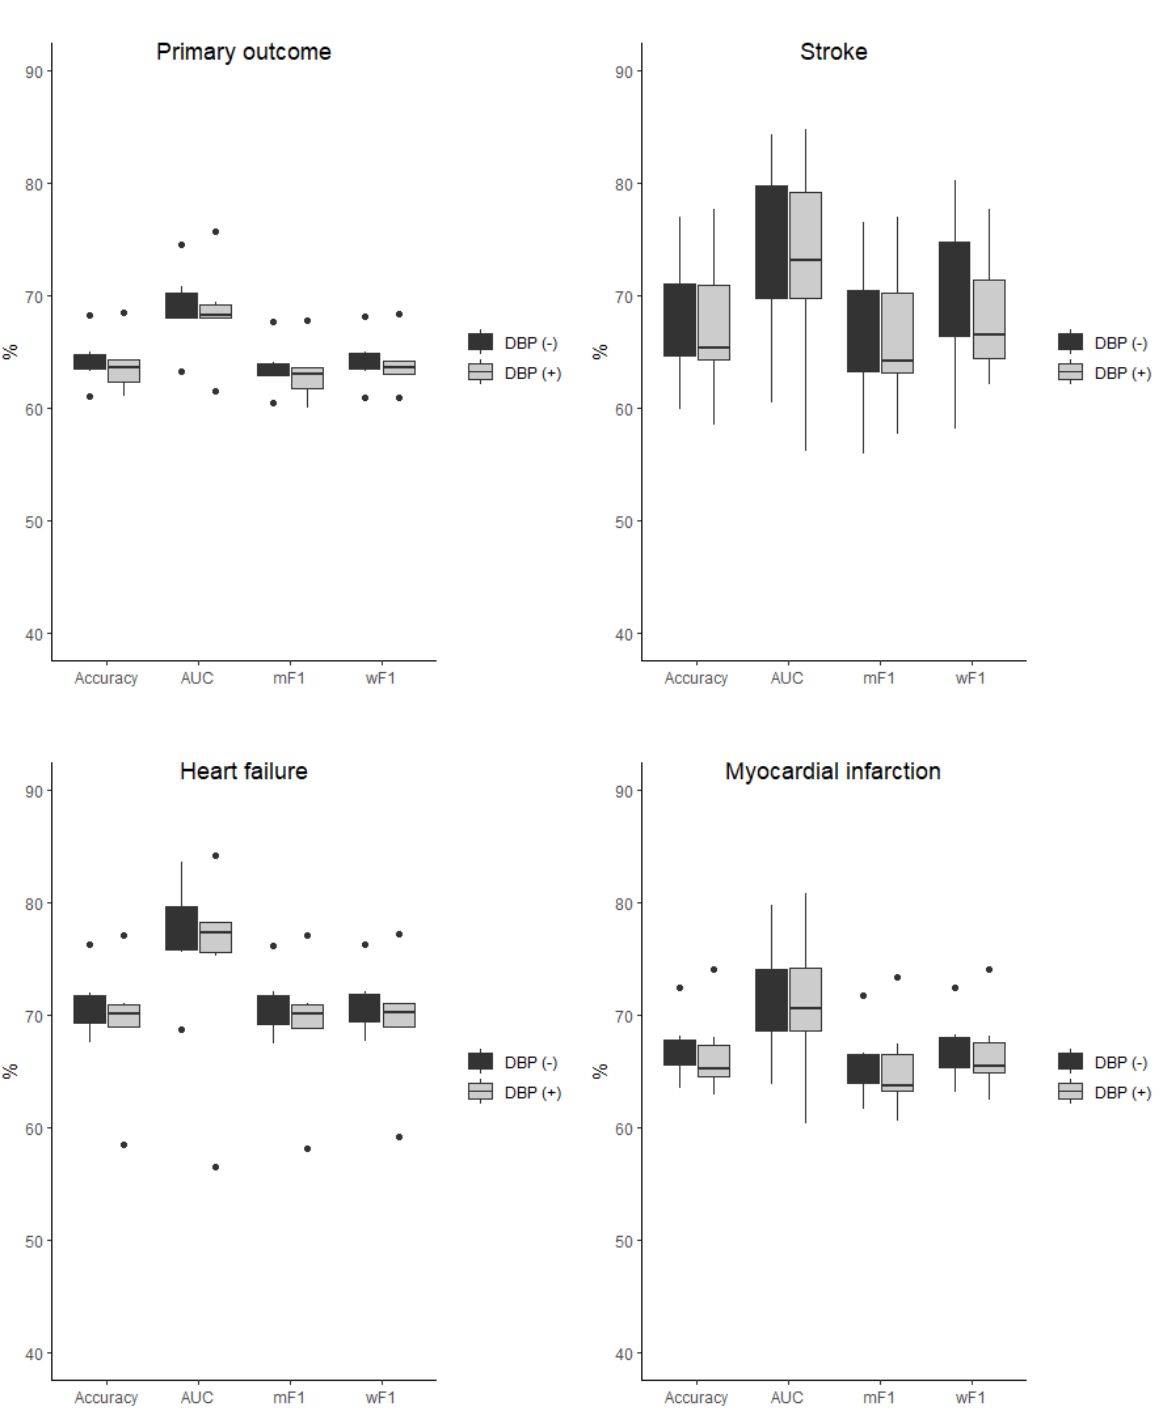
Figure 3. Comparison of the performance of the classifiers when DBP was included (DBP (+)) and excluded (DBP ( − )) as the predictor presented as boxplots for all outcome variables examined in the selected population of subjects with DBP < 70 mmHg. AUC—area under curve, mF1—mean F-measure, wF1—mean weighted F-measure, no differences detected for all of the comparisons.